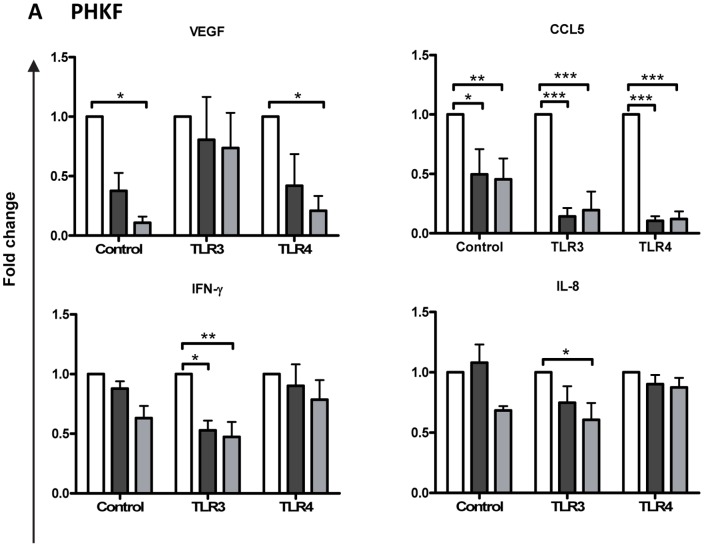
Regulation of cytokine production with Cortisol/Dexamethasone on TLR3 or TLR4 stimulated Primary Human Corneal Fibroblasts (PHKF).Both cortisol (▪, black square) and dexamethasone (▪, gray square) reduced cytokines: VEGF, CCL5, IFN-γ, CXCL-10, IL-8 and GCSF (B) after either or both TLR 3 and 4 stimulation of PHKF. (Values =  Mean+SE, normalising to No Cortisol/Dexamethasone (□, white square) for each treatment n = 3; Statistical analysis 2-way ANOVA with Bonferroni post-test; *p<0.05, **p<0.01, ***p<0.001).